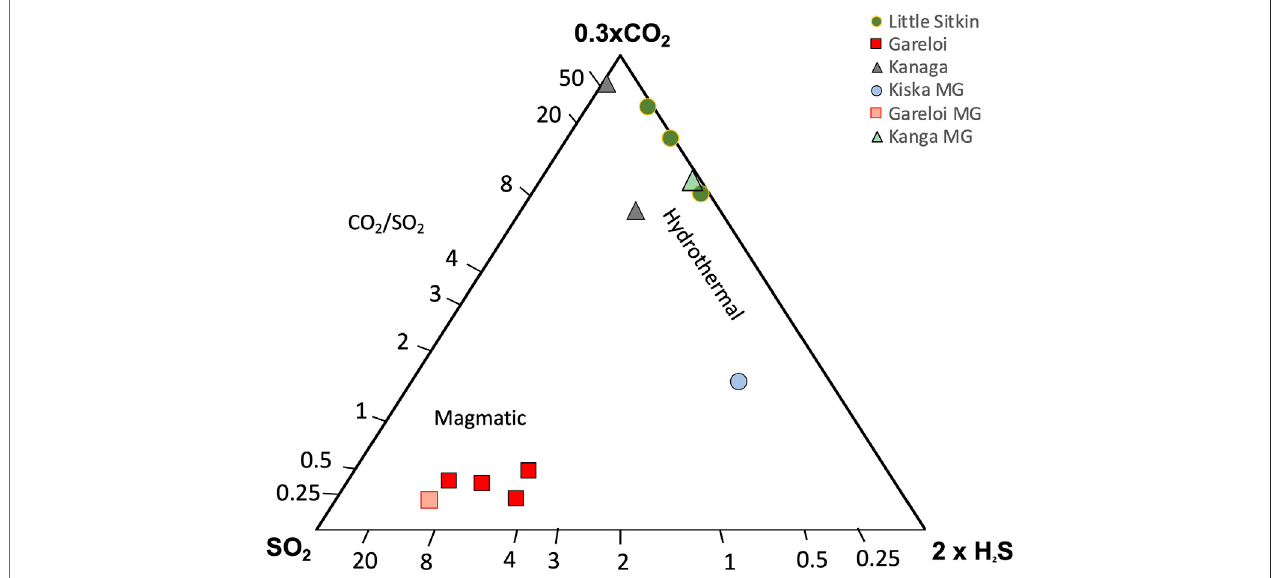
FIGURE8| N 2 ,He,Arrelativeabundancesofgassamplescollectedinthisstudy.AlsoshownaredatafromvolcanoesinAlaskaandtheAleutians(Symondsetal., 2003b; Evans et al., 2015). Subduction zone gases are characterized by high N 2 /He, while upper mantle gases have low N 2 /He at high He/Ar (Giggenbach, 1996).